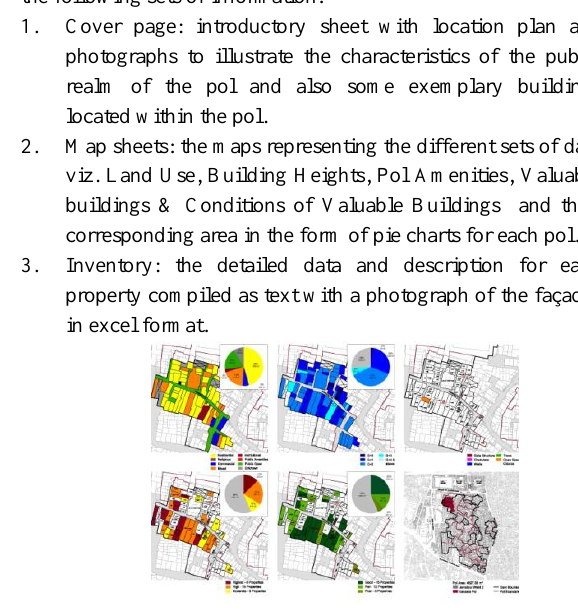
Fig. 2 - A typical presentation of pol